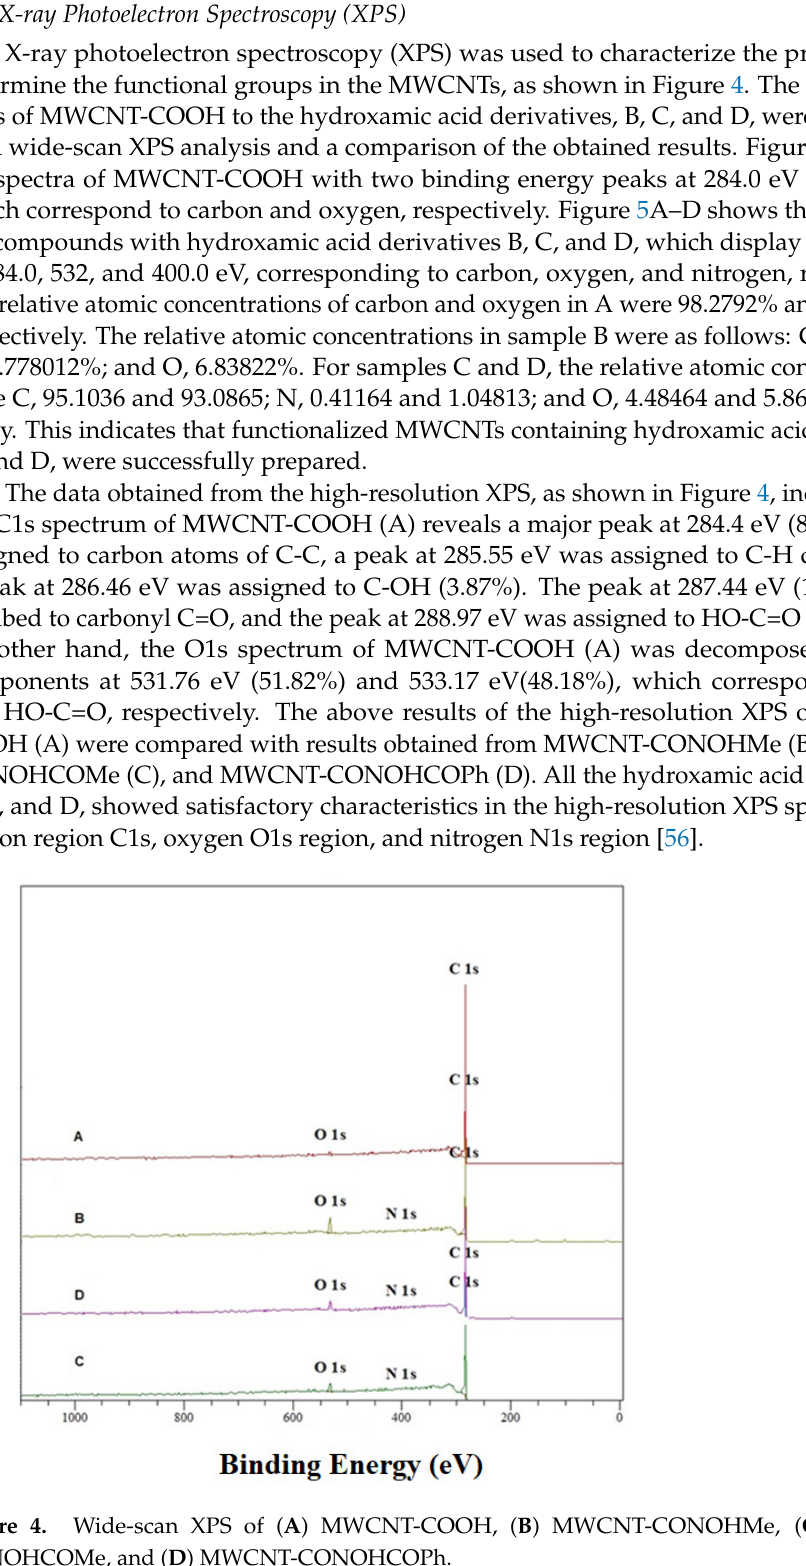
Table 1. Raman shifts (cm − 1 ) of (A) MWCNT-COOH, (B) MWCNT-CONOHMe, (C) MWCNT-CON- OHCOMe, and (D) MWCNT-CONOHCOPh.